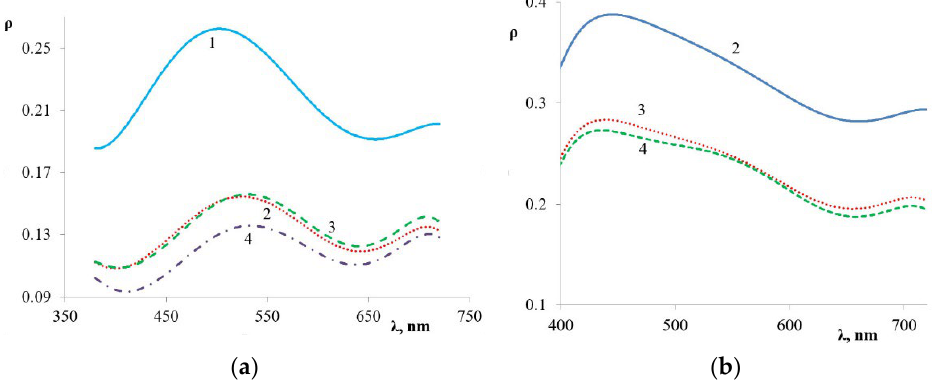
Figure 7. Reflection spectra of core/shell pigment samples with ( a ) doped and ( b ) undoped PANi coating. PANi content in the core/shell pigment (wt.%): 1—5; 2—20; 3—33; 4—50.